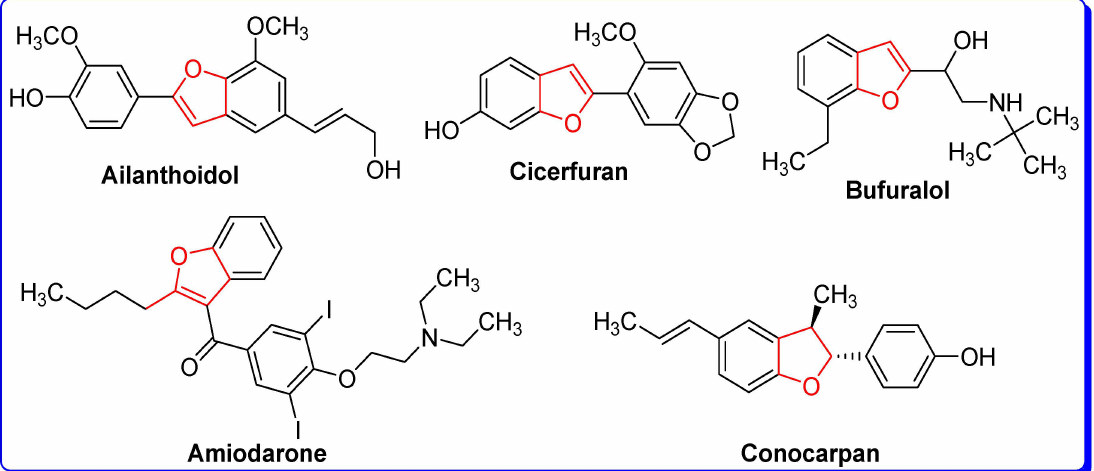
Figure 3. Natural and synthetic furan